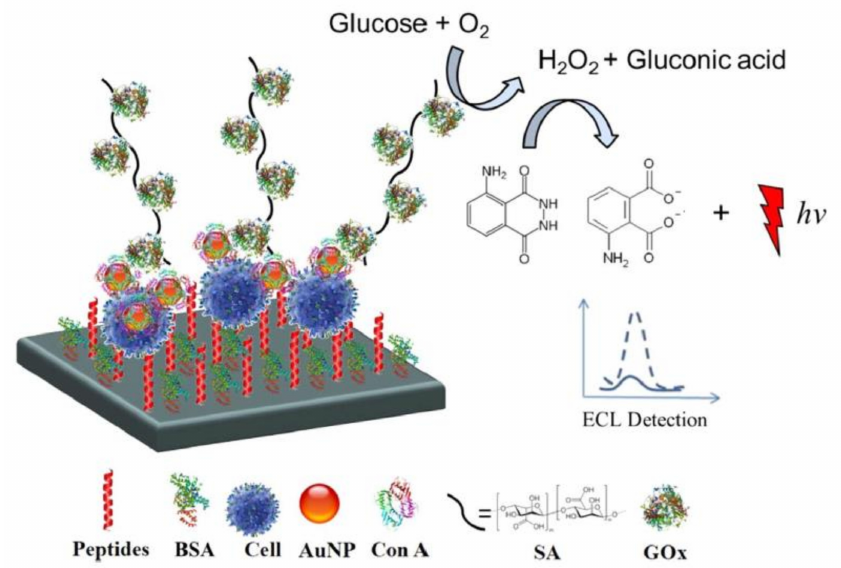
Figure 6. Schematic illustration of the luminol-H 2 O 2 system with a glucose oxidase-conjugated sodium alginate (GOx@SA) nanoprobe for the detection of cell surface glycans. Glucose oxidase on the nanoprobe catalyzes the oxidation of glucose to produce hydrogen peroxide, which improves the ECL signal. Reproduced with permission from